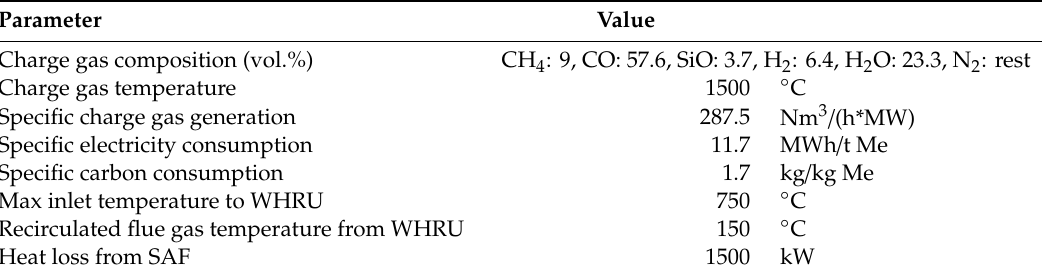
Table 2. Ferrosilicon production base case